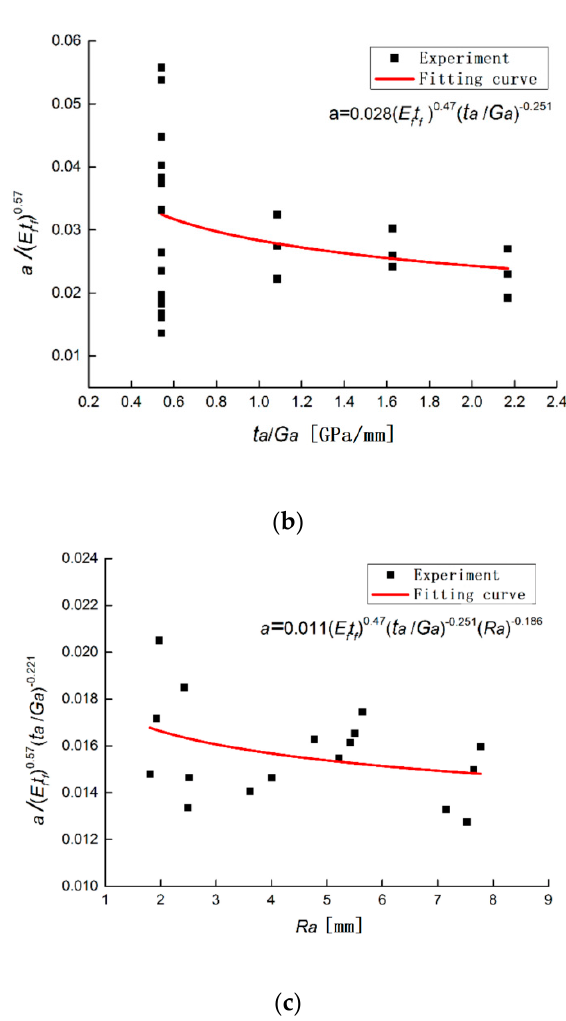
Figure 7. Effect of different factors on the parameter a: ( a ) Testing group of the specimen with different Figure 7. E ff ect of di ff erent factors on the parameter a: ( a ) Testing group of the specimen with di ff erent CFRP fabric stiffnesses; ( b ) Testing group of the specimen with different glue thicknesses. ( c ) Testing CFRP fabric sti ff nesses; ( b ) Testing group of the specimen with di ff erent glue thicknesses. ( c ) Testing group of the specimen with different surface roughnesses. group of the specimen with di ff erent surface